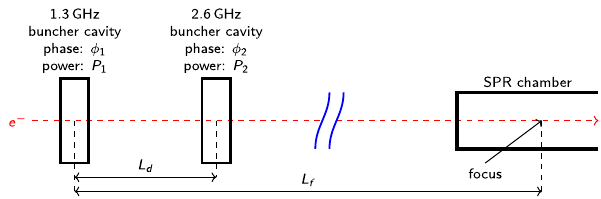
FIG. 4. Principle of longitudinal bunch compression using two